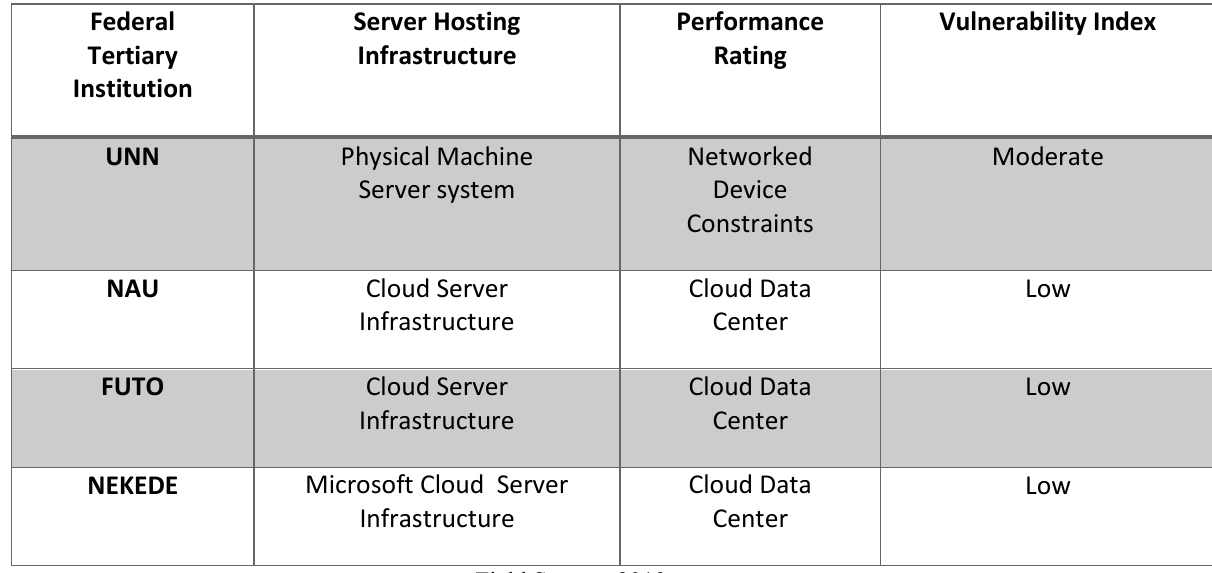
Table 2. Institutional CIT Server